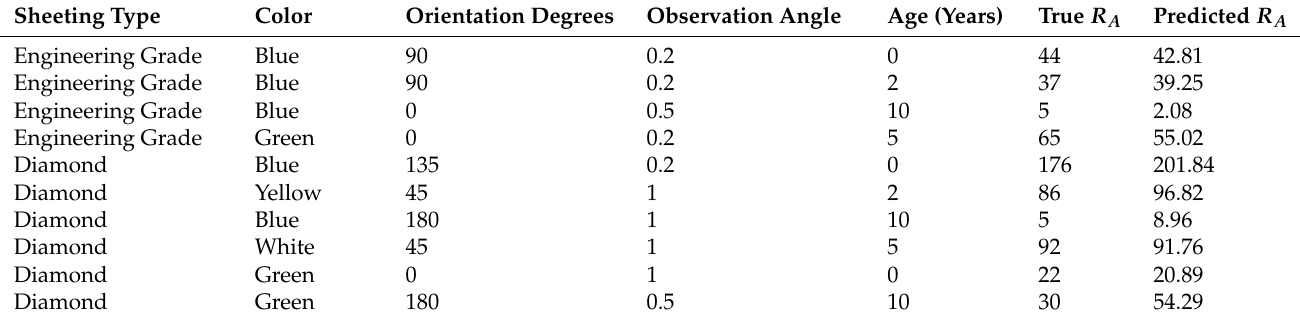
Table 5. Samples from the test sets and predicted R A by our proposed NN with one-hot encoding.